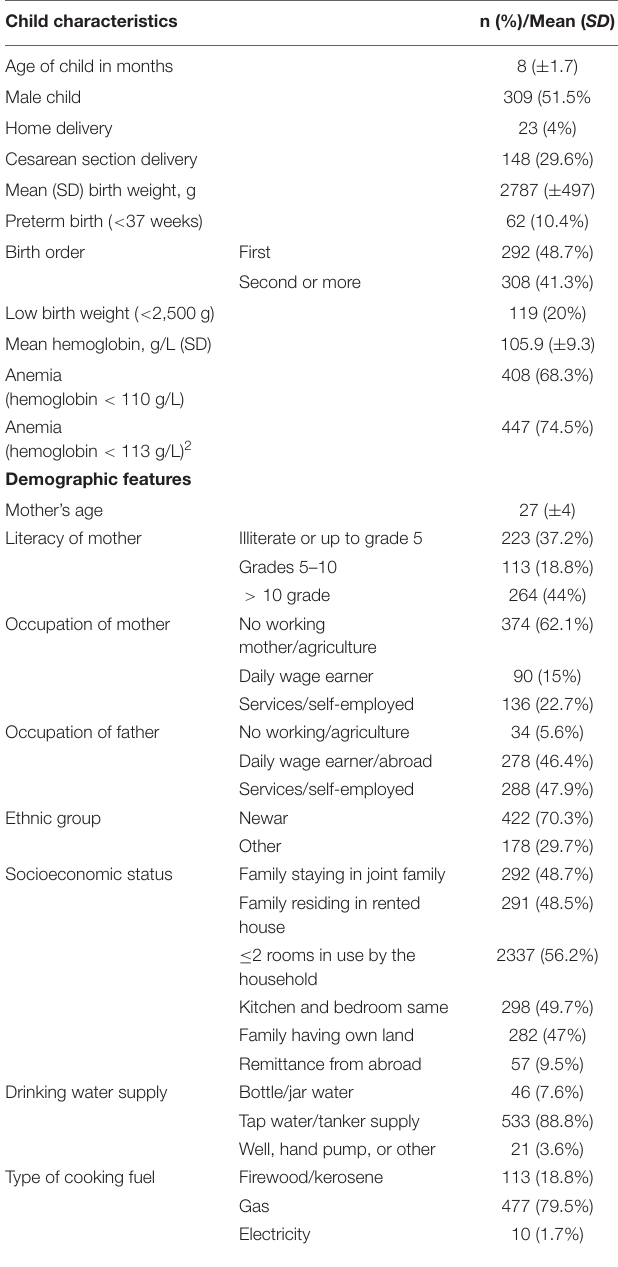
TABLE 2 | Baseline information of 600 Nepalese infants in the Alarm Distress Baby Scale study. Child